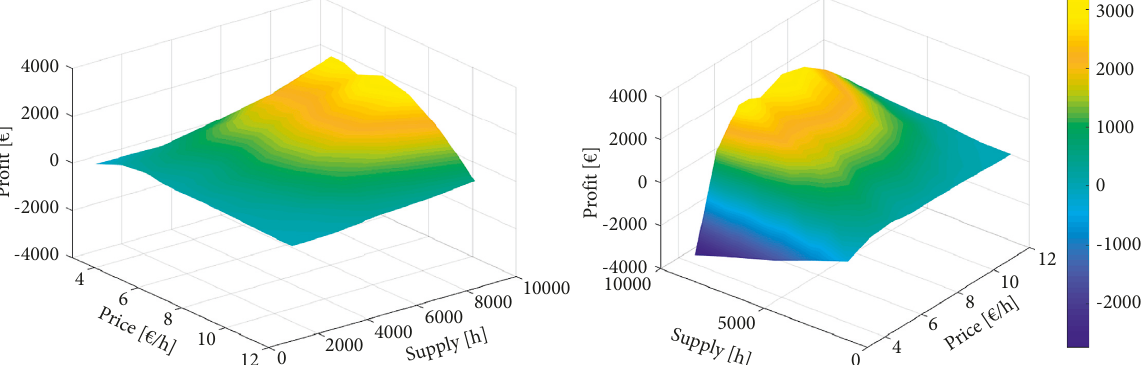
Figure 9: Profit in function of supply and price variation.